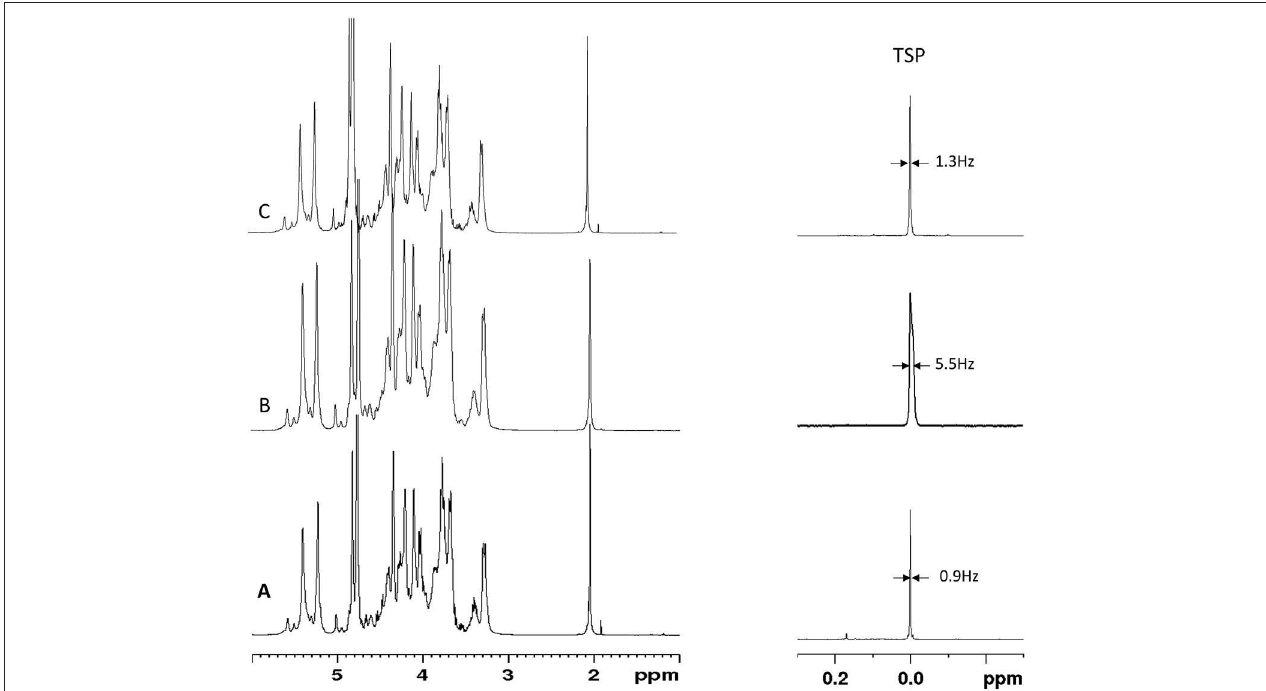
FIGURE 6 | Proton spectra of PMH sample provided by USP measured by Laboratory 1 (A) and Laboratory 2 (B,C) . TSP signal and the corresponding width at half height is reported.